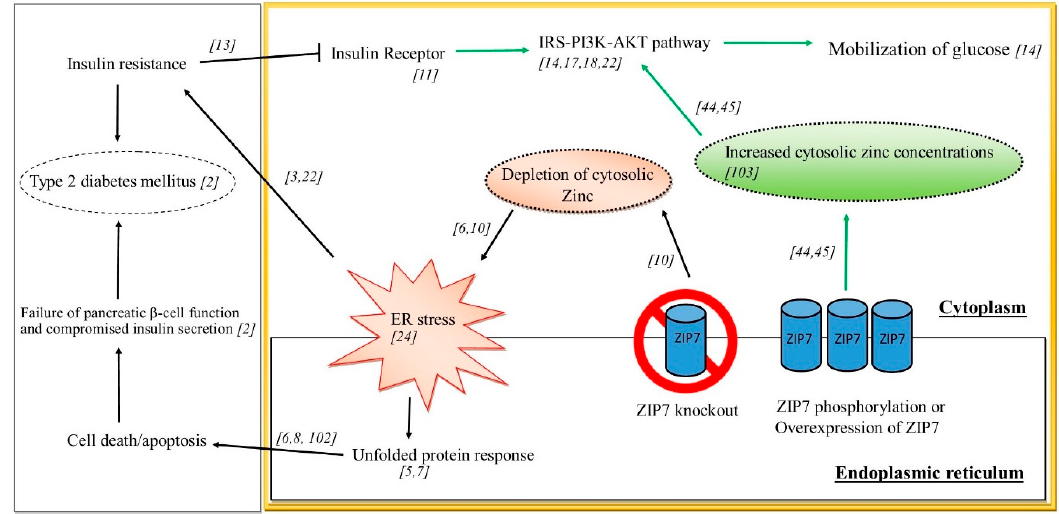
Figure 2. Schematic diagram of ZIP7 and its role in regulating pathways involved in glucose mobilization, ER stress, IR and